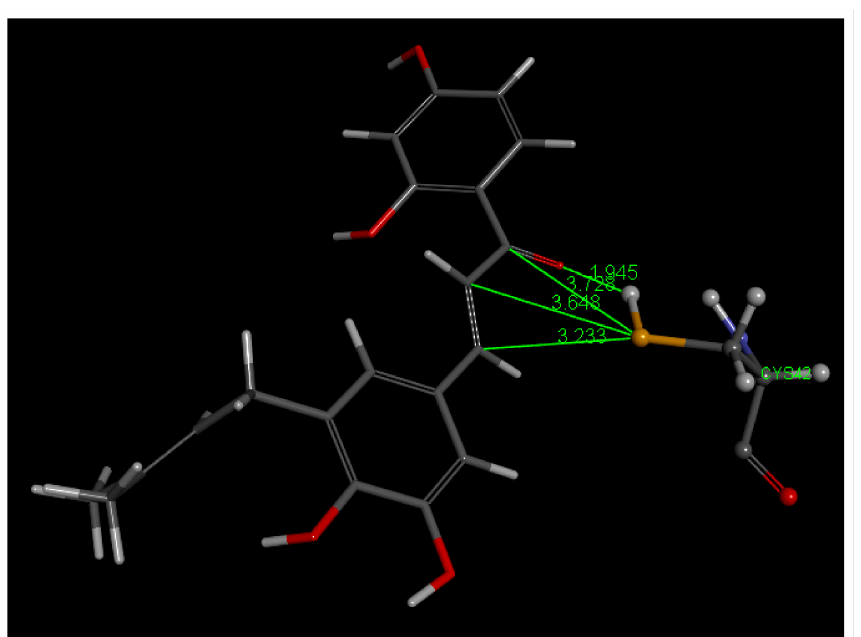
Figure 26. This is pose 3 after docking 5-Prenylbutein ( 4 ) in the 3BPF receptor, showing more details. A potential capture of H[S(Cys42)] by chalcone O(carbonyl), 1.945 Å, is envisioned, along with S(thiolate) nucleophilic attack to C(carbonyl), 3.728 Å, or, more probably, C(ethenyl) β carbon, 3.233 Å.